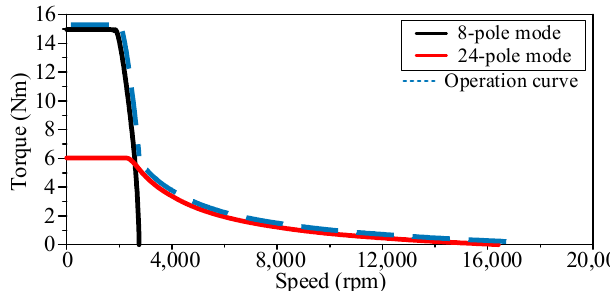
Figure 13. The torque–speed curves.